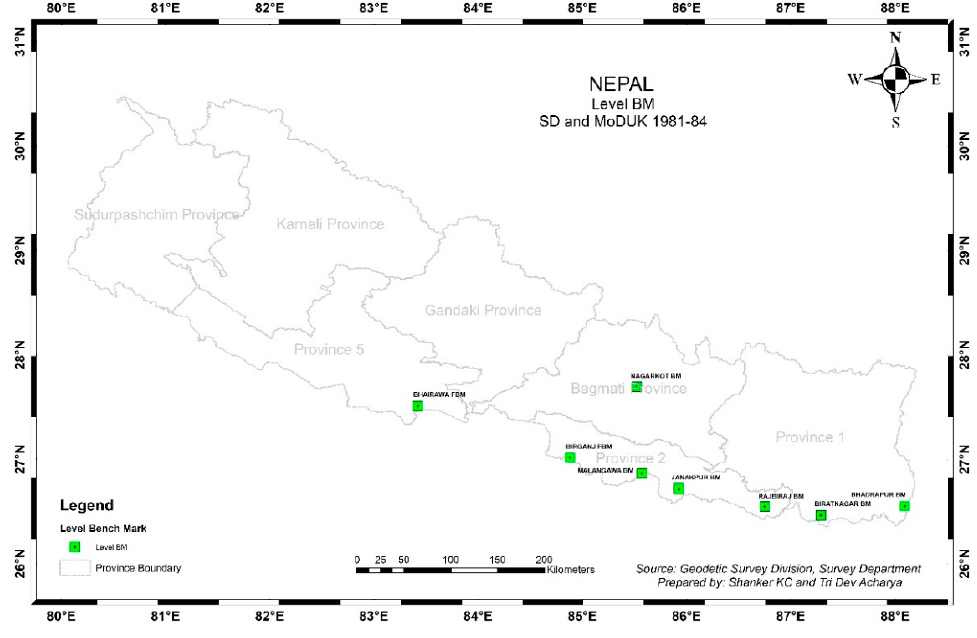
Figure 8. Level BMs surveyed by SD during 1981–1984 [8].